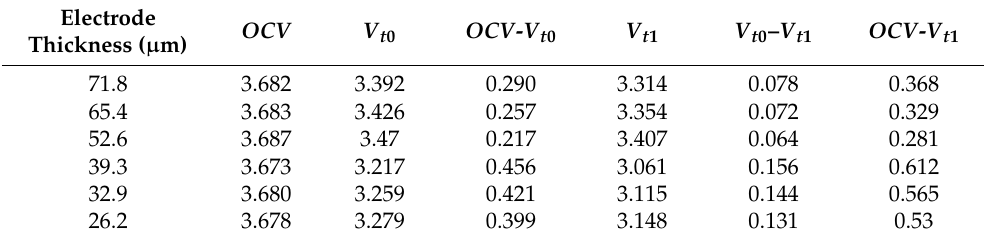
Table 4. The voltage change of the cell during pulse discharge.